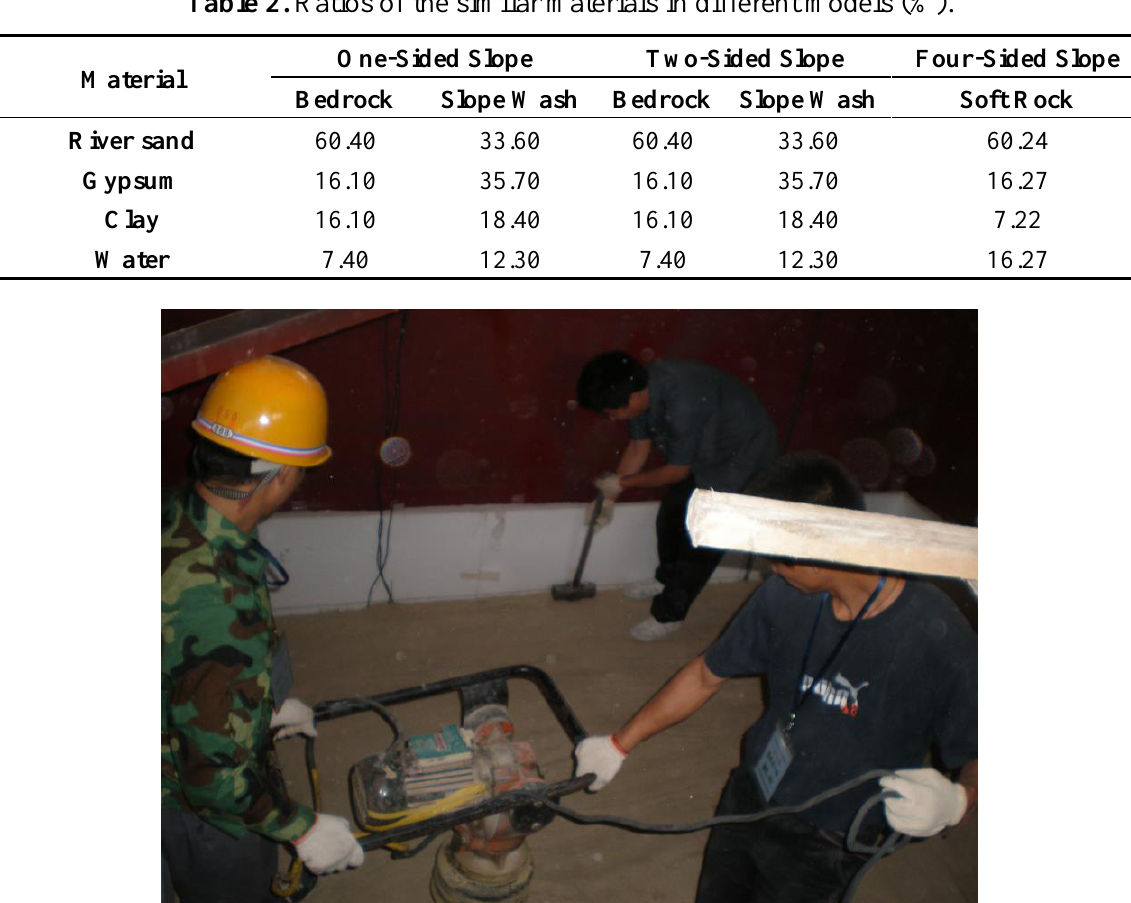
Table 2. Ratios of the similar materials in different models (%).